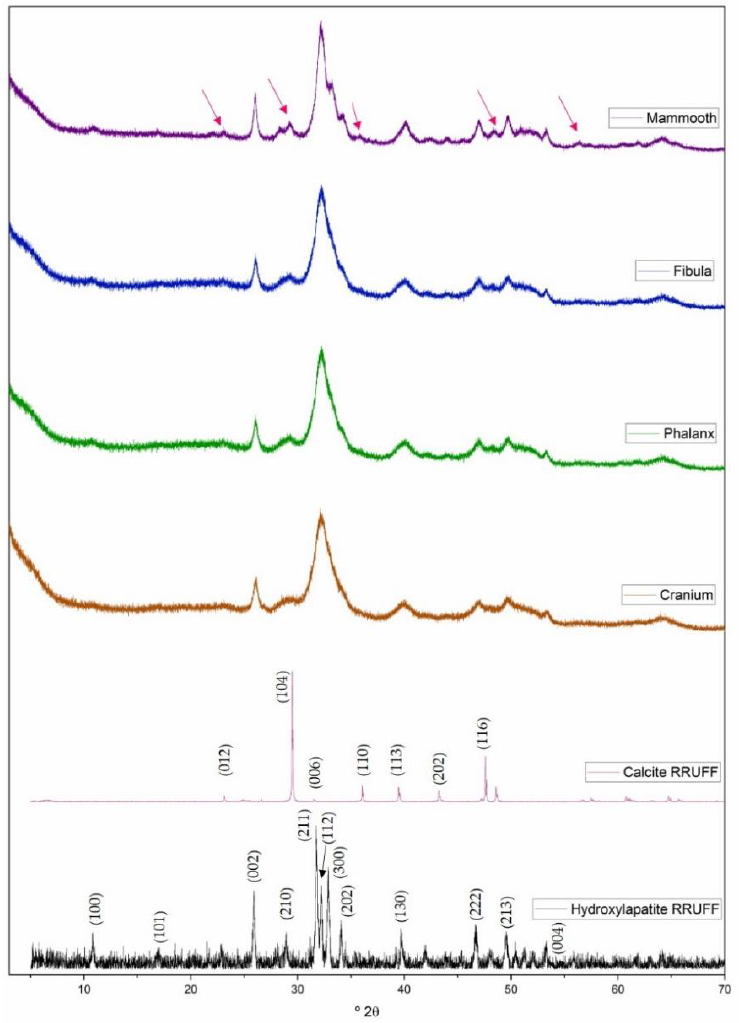
Figure 1. XRD patterns of bone samples and reference patterns of hydroxyapatite and calcite phases. Red arrows in the mammoth diffraction pattern correspond to diffraction peaks of CaCO 3 . Table 1. Rietveld calculations of lattice parameters (i.e., a - and c -axes values, expressed in Angstrom - Å ) of hydroxyapatite crystals in bone mineral, the goodness of fitting (GoF) for these crystalline analyses, and the crystallite size ( D ) for all bone samples. Sample